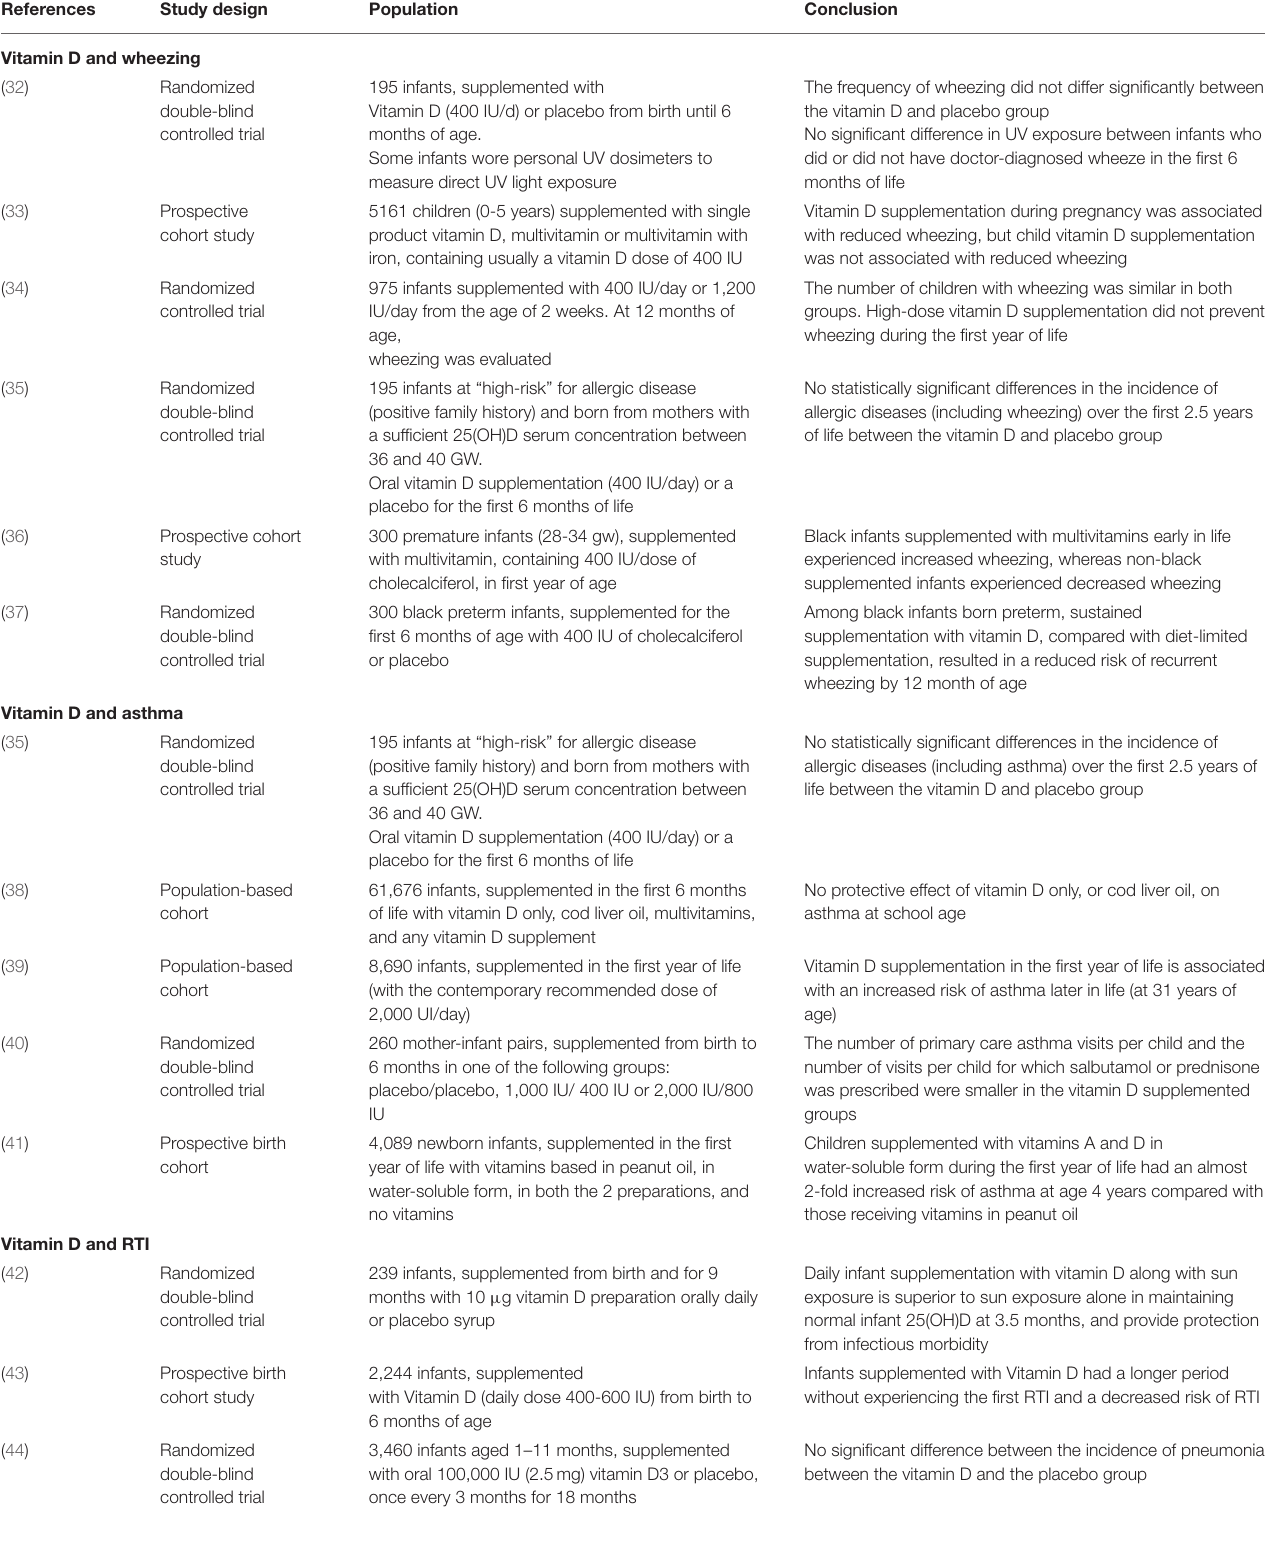
TABLE 2 | Main features and results of studies investigating active supplementation of Vitamin